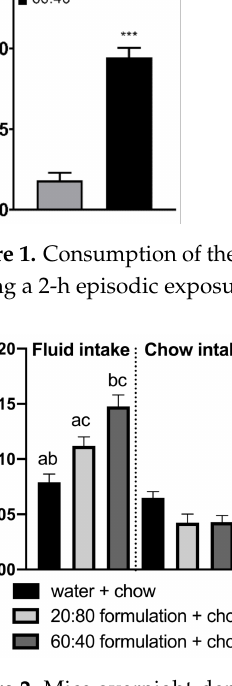
Figure 2. Mice overnight-deprived of food and refed for 2 h with Control 20:80 whey:casein formula + chow or with the 60:40 whey:casein formula + chow or with water + chow most avidly ingested the 60:40 formula followed by the Control 20:80 solution and water. a—significantly different from the 60:40 control formula intake; b—significantly different from the 20:80 formula intake; c—significantly different from the water intake. Significant when p <